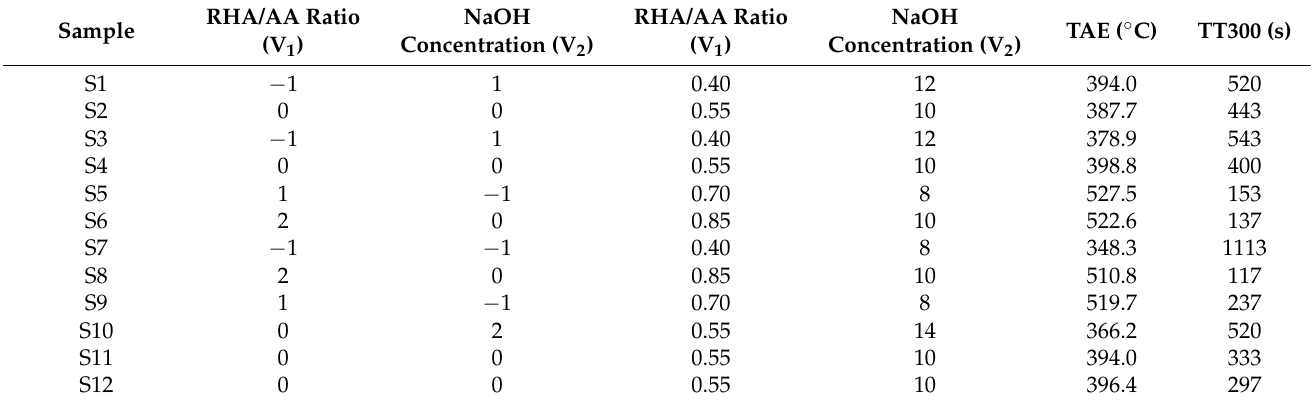
Table 5. Design matrix and response value for the temperature at equilibrium (TAE) and time taken to reach 300 ◦ C (TT300).